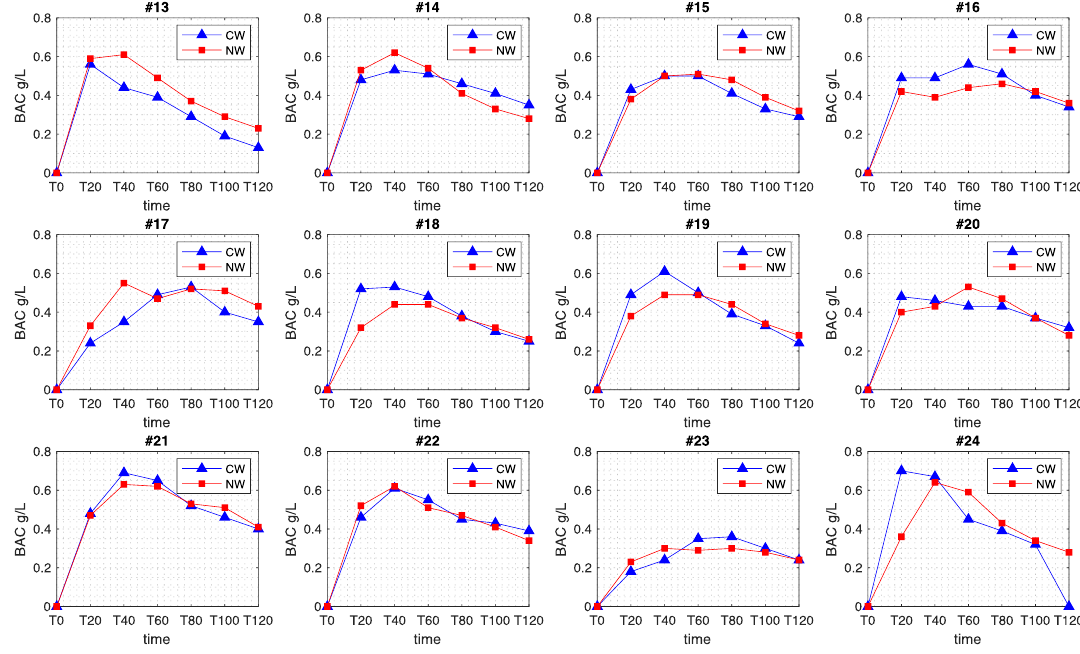
Figure A2. Concentration – time curves of BAC responses to natural wine and conventional wine for subjects #13 – #24.